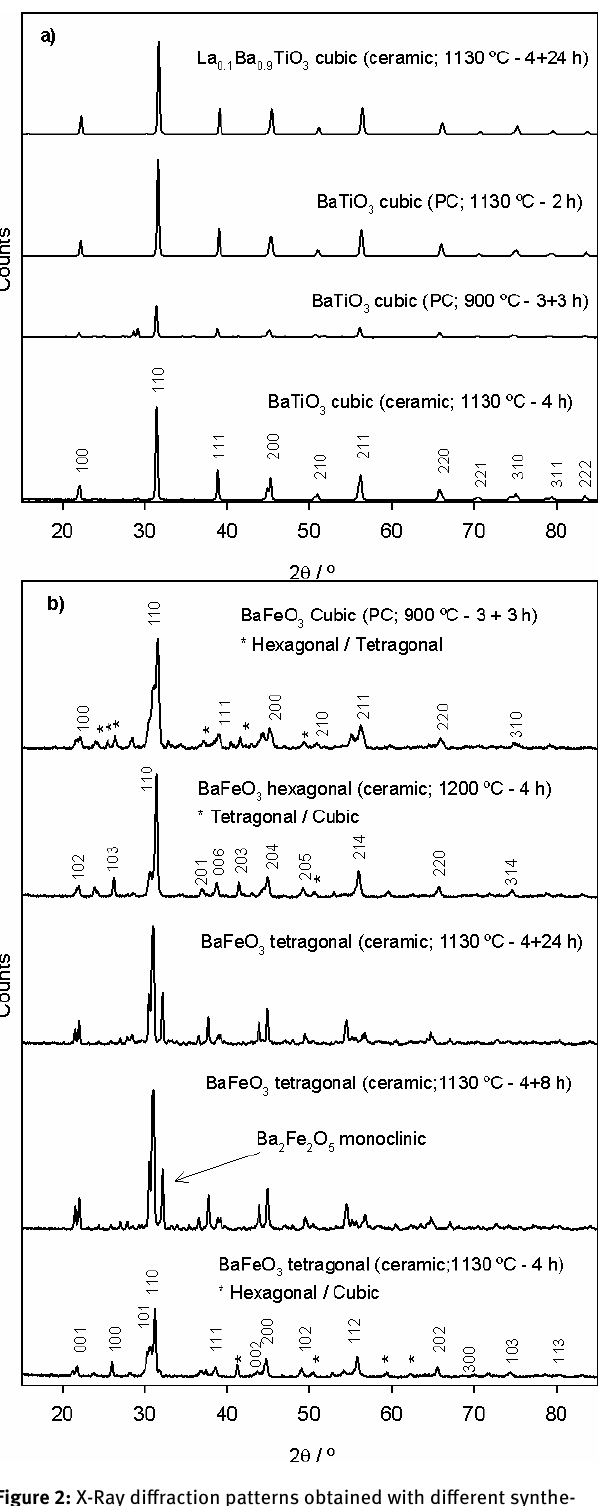
Figure 2: X-Ray diffraction patterns obtained with different synthe- sis methods and annealing conditions for the different perovskite powders: a) La x Ba (1− x ) TiO 3 ; b) BaFeO 3